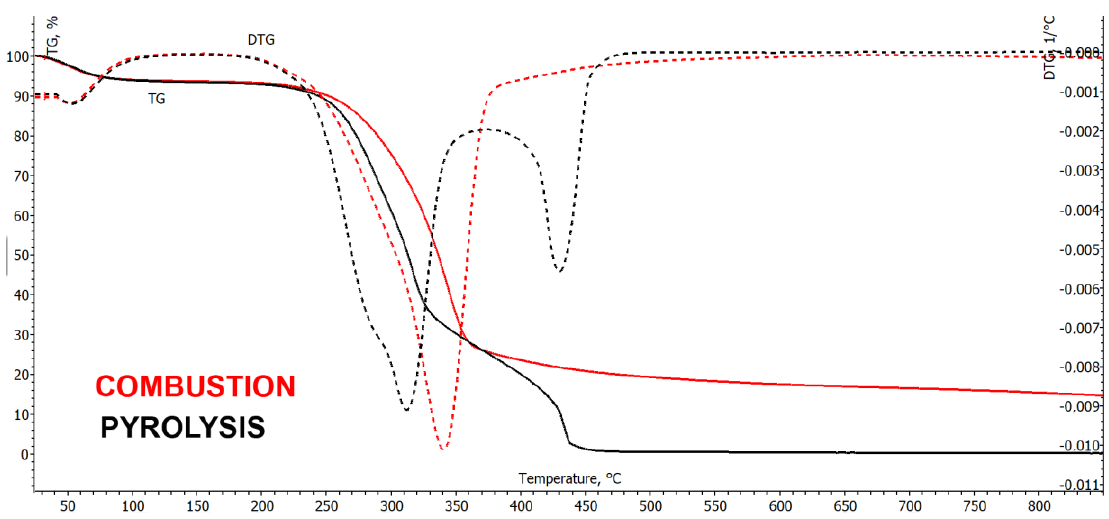
Figure 5. Comparison of the combustion and pyrolysis processes of pine sawdust using the thermogravimetric method, with a heating rate of 10°C/min.